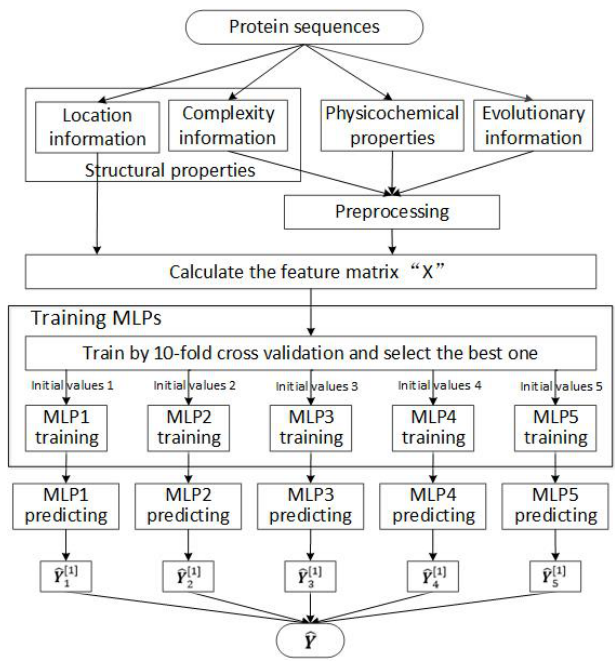
Figure 2. The detail paradigm of our